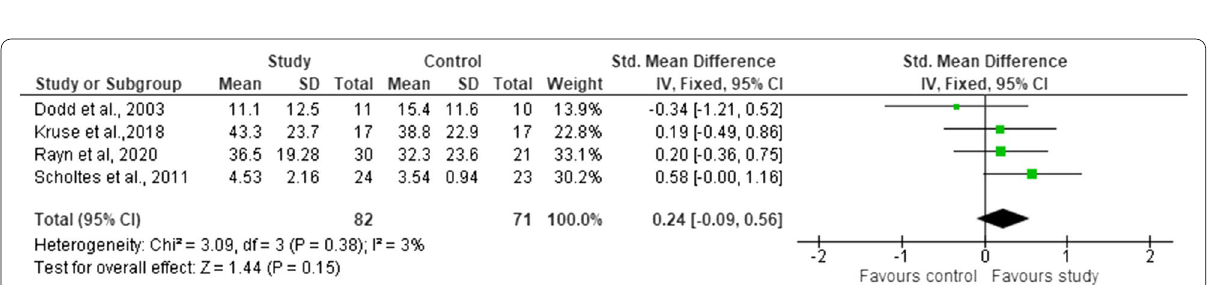
Fig. 5 Forest plot of comparison between study and control groups regarding plantar flexors strength — post-intervention